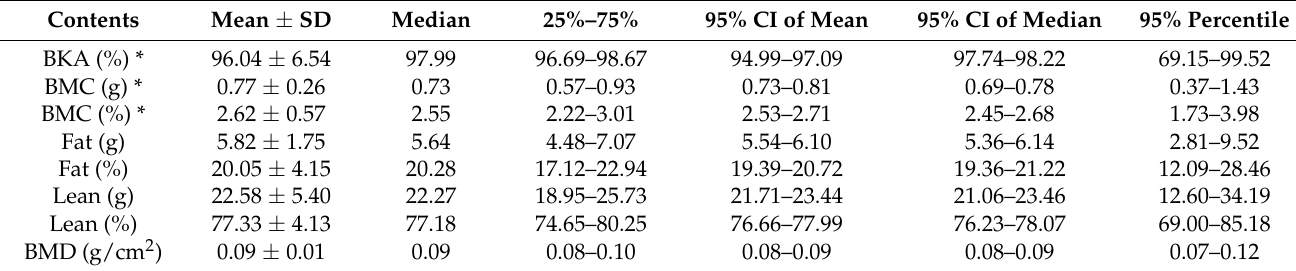
Table 1. The mean ± standard deviation (SD), median, first (25%) to third (75%) quantile range, 95% confidence interval (CI) of mean and median, and 95% percentile (2.5–97.5% range) of immunity, body composition, and bone mineral density (BMD) in 151 black-spotted pond frogs. Bacterial killing ability (BKA) was analyzed to represent the immunity. Body composition was composed of bone mineral contents (BMC), fat contents (fat), and lean body contents (lean). We calculated each body composition ratio (%) by dividing the total body weight by each body composition mass. The asterisk (*) represents the components that are not normally distributed.